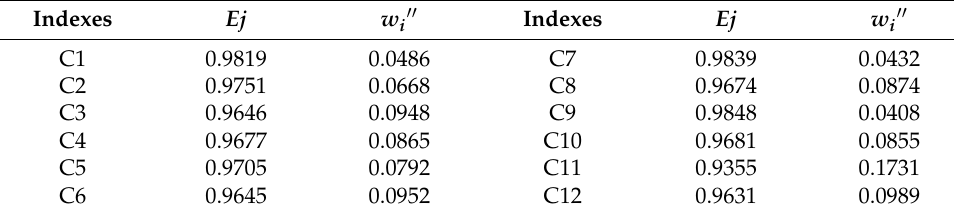
Table 4. Calculation results of objective weight ( w i (cid:48)(cid:48) ) by the entropy weight method.